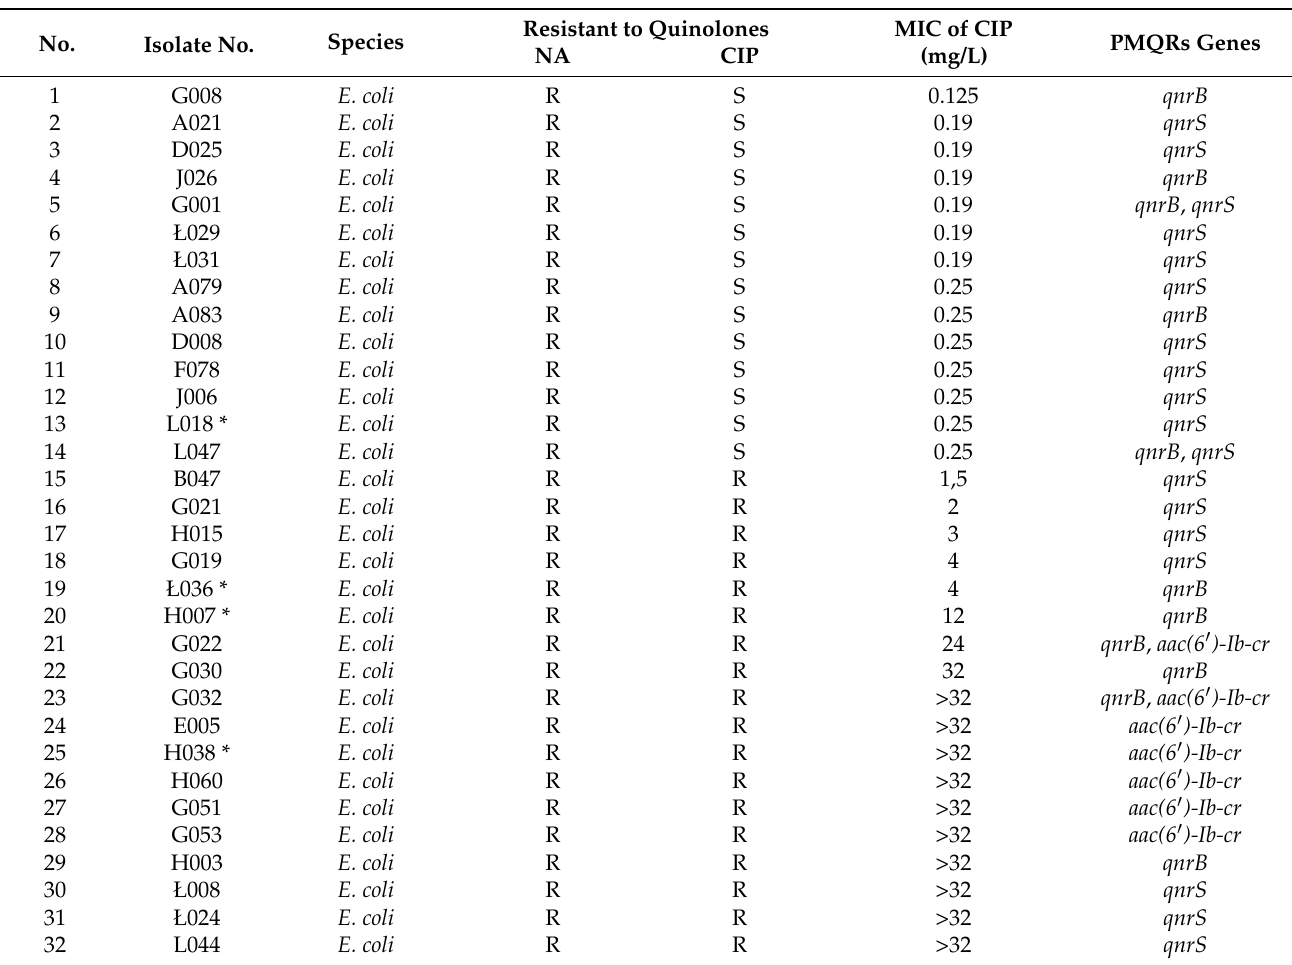
Table 1. Distribution of plasmid-mediated quinolone resistance (PMQRs) determinants among different FQ-resistant phenotypes of 32 E. coli strains isolated from rectal swabs of men undergoing a transrectal prostate